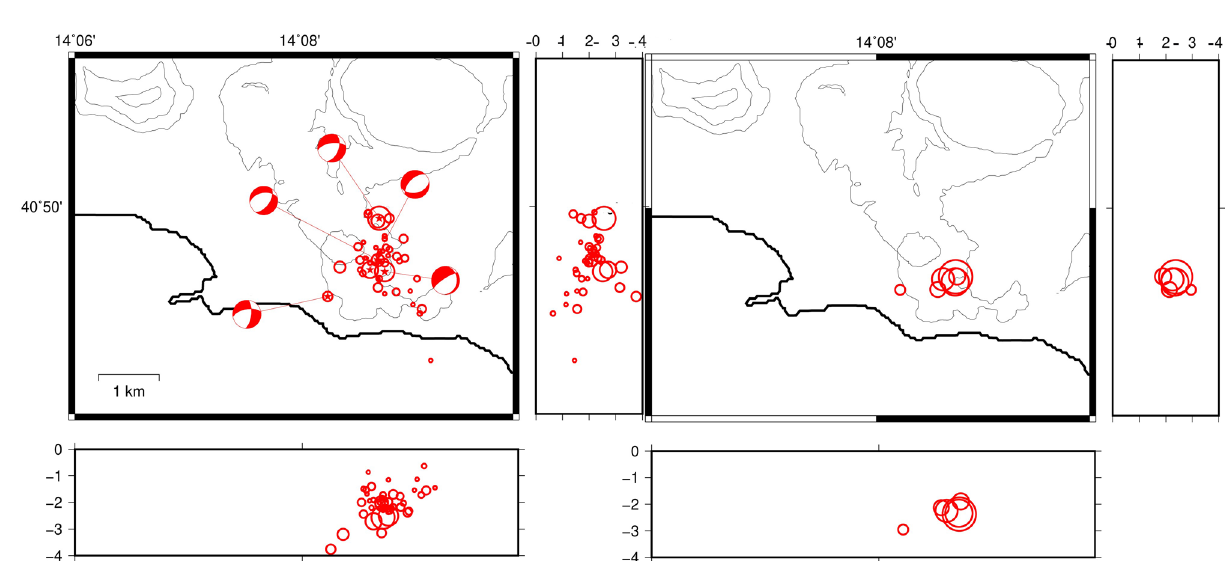
Figure 7. Location of the earthquakes of the swarm of 26/04/2020 obtained using (sx) and HypoDD (dx). Circle sizes are proportional to the earthquake magnitude. The images were obtained using the free software GMT 5.3.1 (https:// www. gener ic- mappi ng- tools.